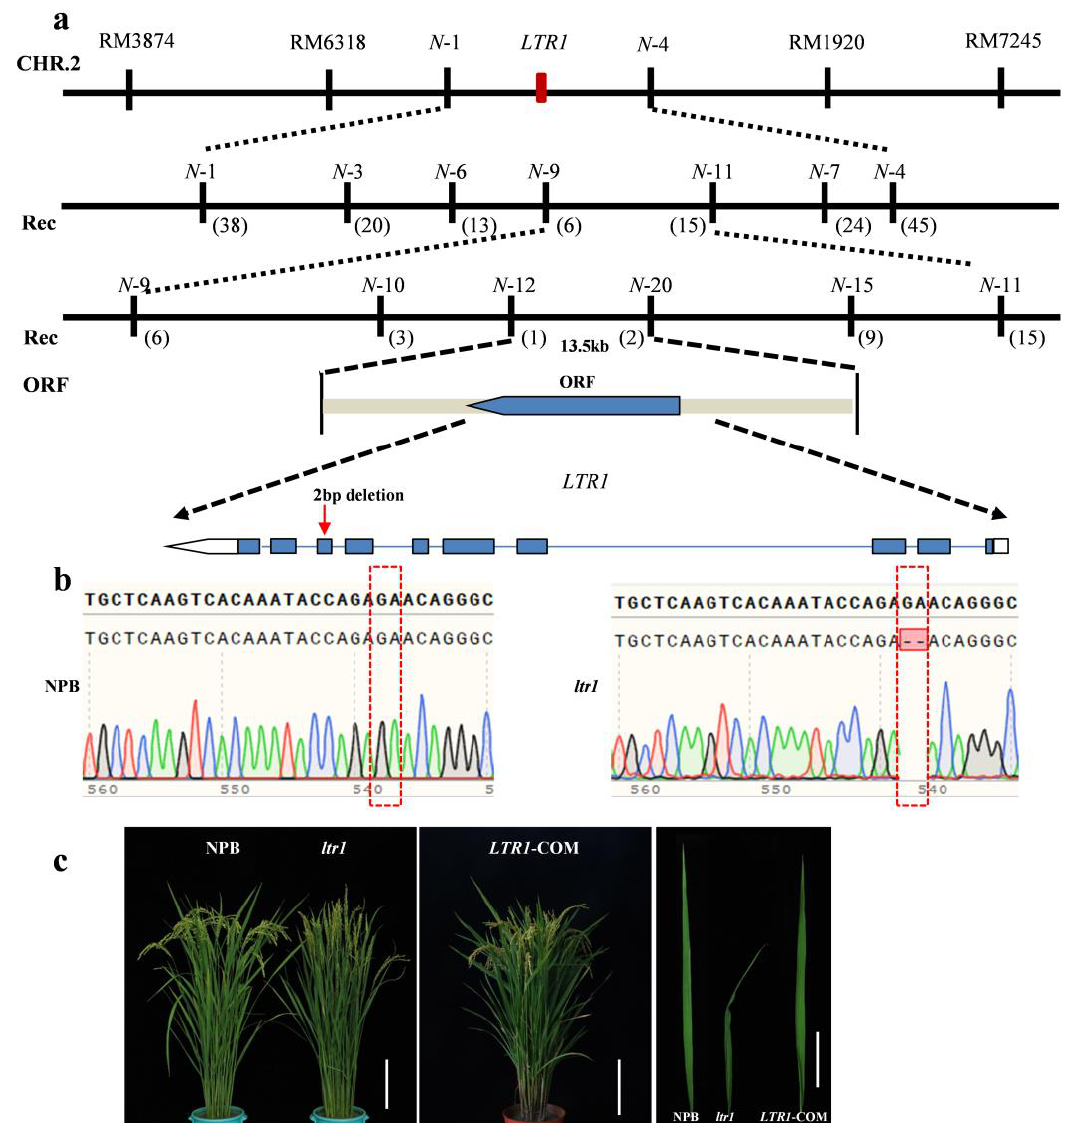
Figure 3. Map-based cloning of LTR1 . ( a ) Fine mapping of LTR1 ; the red arrow represents the mutation site of LTR1 in ltr1 . ( b ) Sequence analysis of NPB and ltr1 ; the red box represents the mutation site in ltr1 . ( c ) Complementary analysis of LTR1 in ltr1 ; bar for plants and leaves was 20 cm and 5 cm,